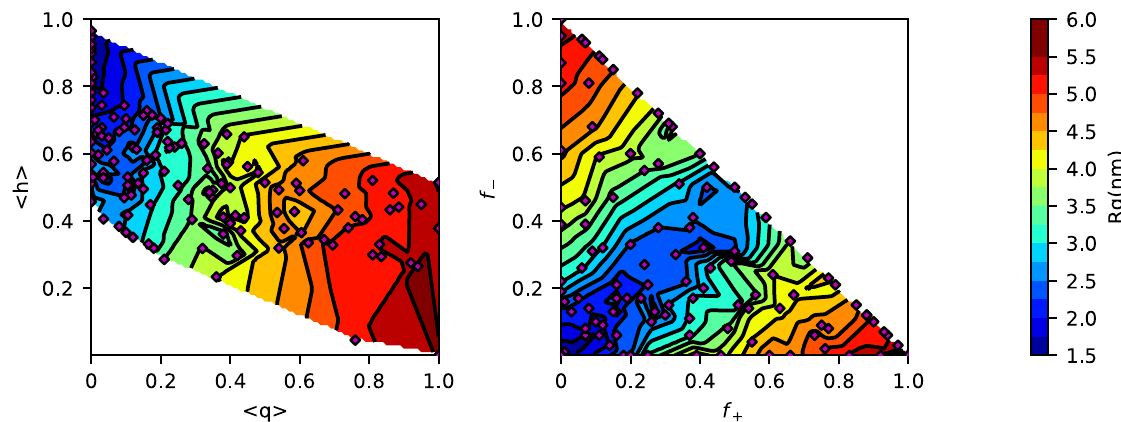
Fig 3. Randomly generated sequences of 100 amino acids follow the general trends expected from an Uversky type plot (left) and Pappu type plot (right). Axes are: mean hydrophobicity per residue h h i , mean net charge per residue, h q i and fractions of positively f + and negatively f charged residues. For both plots, the color represents average R − each tested sequence is represented by a purple